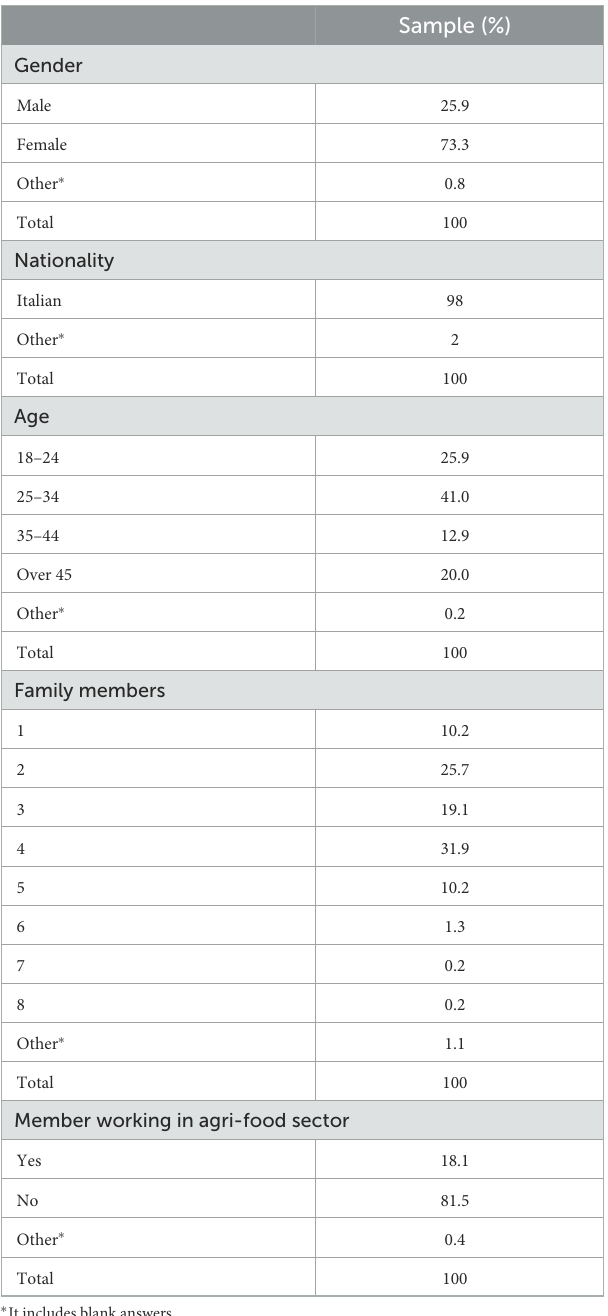
different steps (Figure 2): Step (1) literature review, Step (2) semi- structured online interviews with consumers and validation of